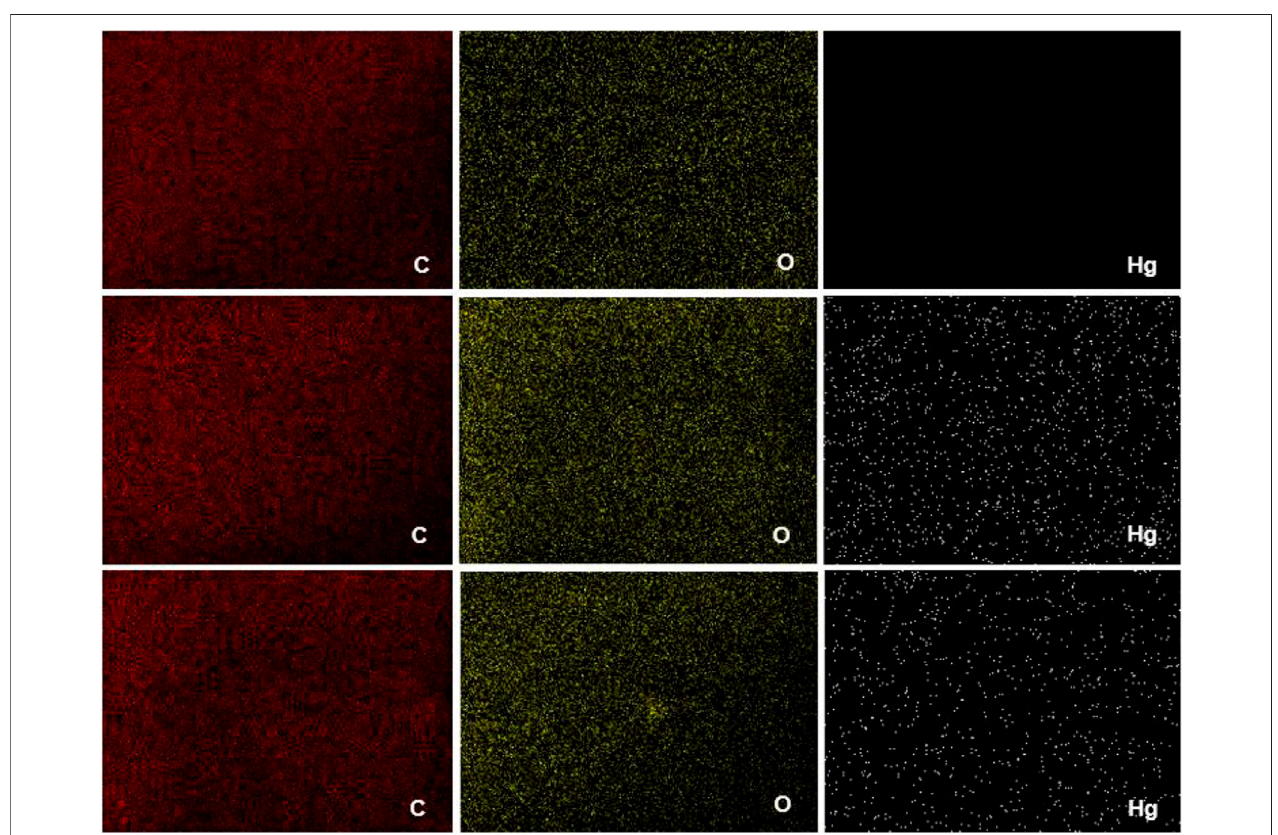
FIGURE 8 | Distribution of elements by EDS